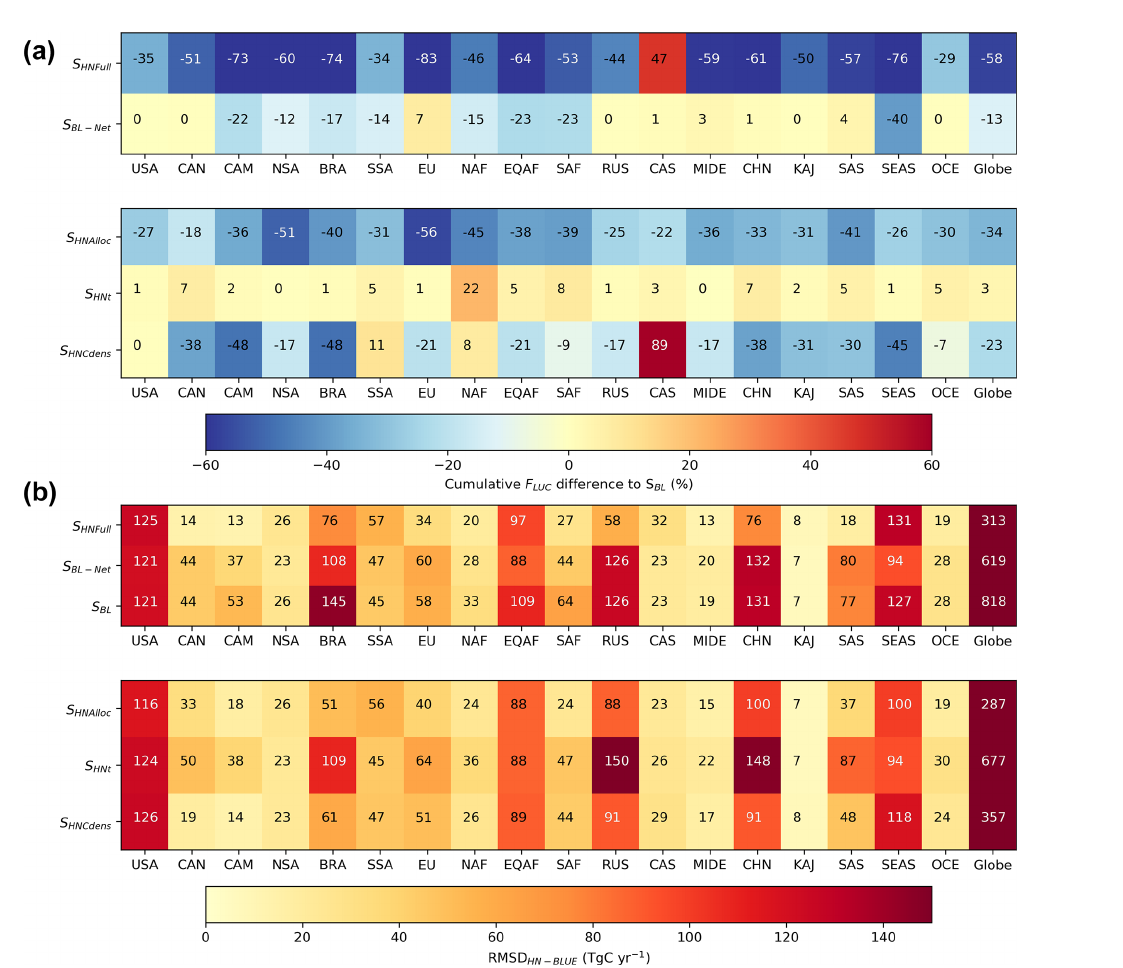
Figure 4. (a) Relative changes in cumulative simulated F LUC between 1850–2015 for each region for S BL-Net and S HNFull compared to S BL (top two rows) and the relative effect of each parameter change, compared to S BL-NET (bottom three rows) indicated by the colours and numbers in the centre of cells. (b) The RMSD HN-BLUE for each simulation indicated by the colours and numbers in the centre of cells. All panels show results for the period